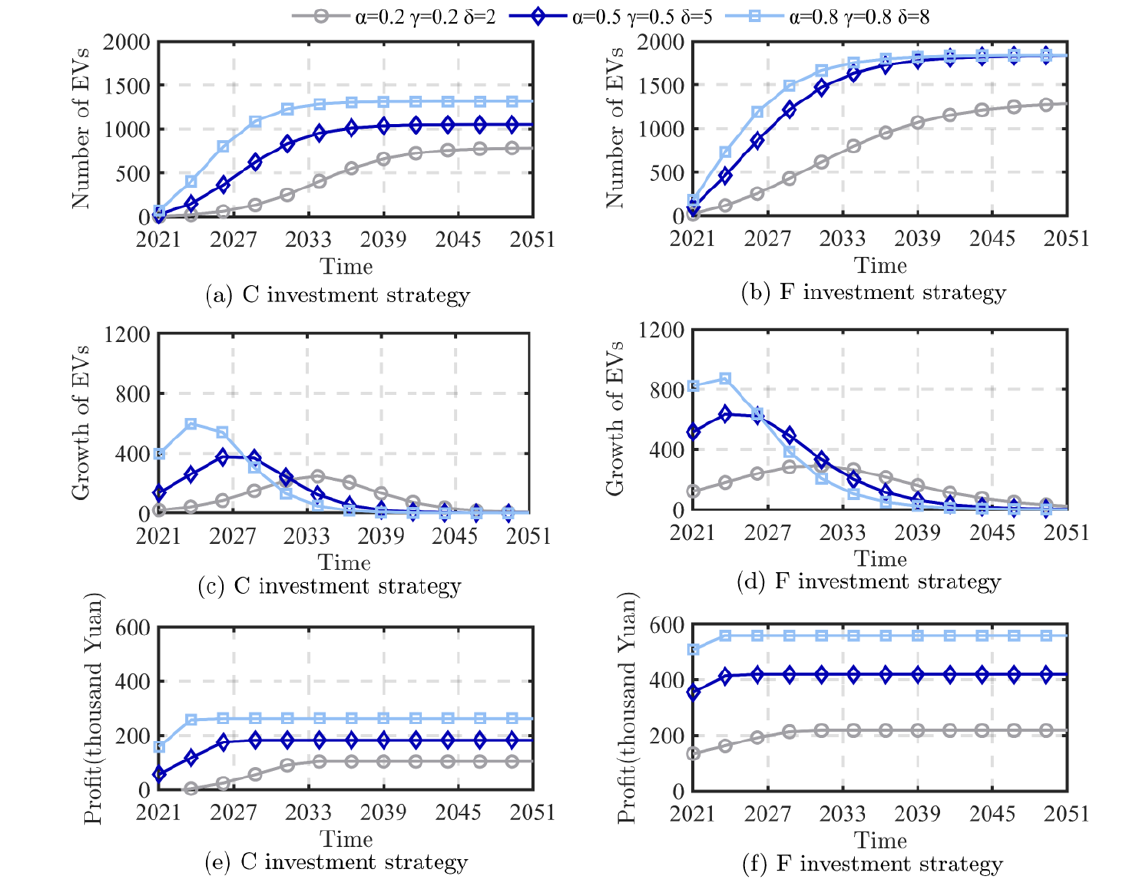
Figure 12. Number of EVs and growth of EVs and profit changes with 𝛼 and 𝛾 and